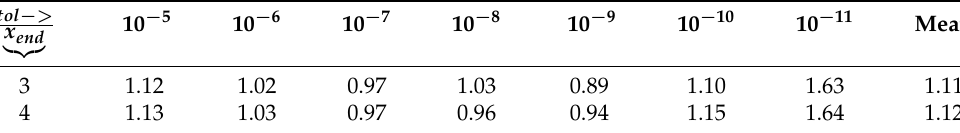
Table 8. Efficiency measures ratios of DLMP6(5) vs. NEW6(5) for